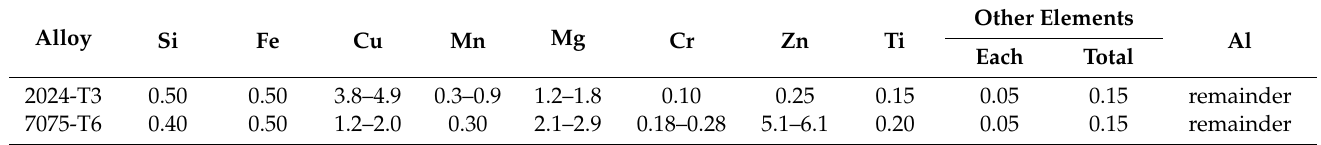
Table 1. Chemical composition of test sheets in wt.% [40].